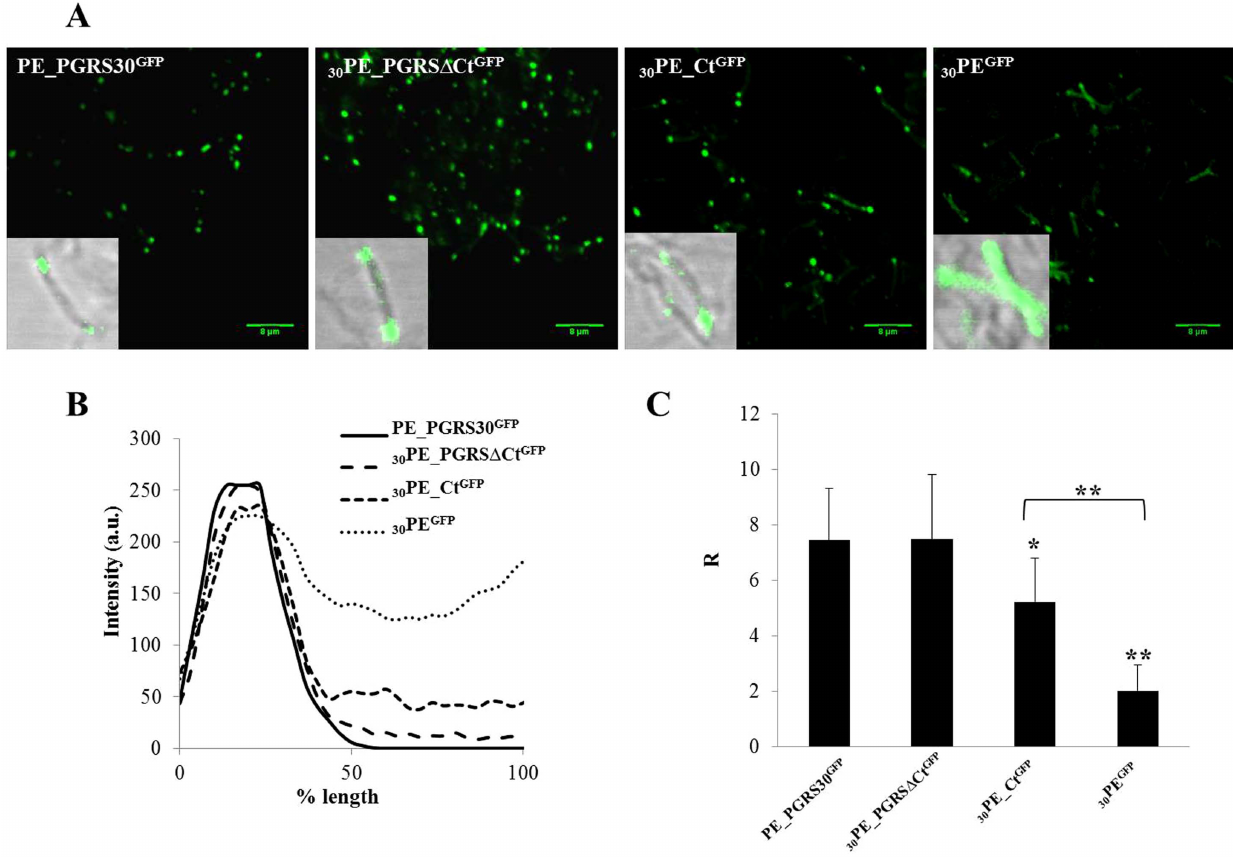
Figure 2. Polar localization of PE_PGRS30 GFP spatial distribution in Mtb . A) Confocal images of Mtb H37Rv expressing PE_PGRS30 GFP and its functional GFP-tagged chimeras obtained with a 63 6 objective. In the inbox, a 100 6 image obtained overlapping green channel and transmission image is shown. B) Sample line profile obtained quantifying the fluorescence along mycobacterial cell. C) Ratio between the GFP emission intensity at bacterium pole (considered as the value 200 nm far from the bacterium border) and GFP emission intensity in the cytoplasm (measured at the 50% of the bacterium length). Twenty R values were analyzed for each Mtb strain under study. Two-tailed Student’s t -test was used to analyze R ratio ( * p , 0.05, ** p ,